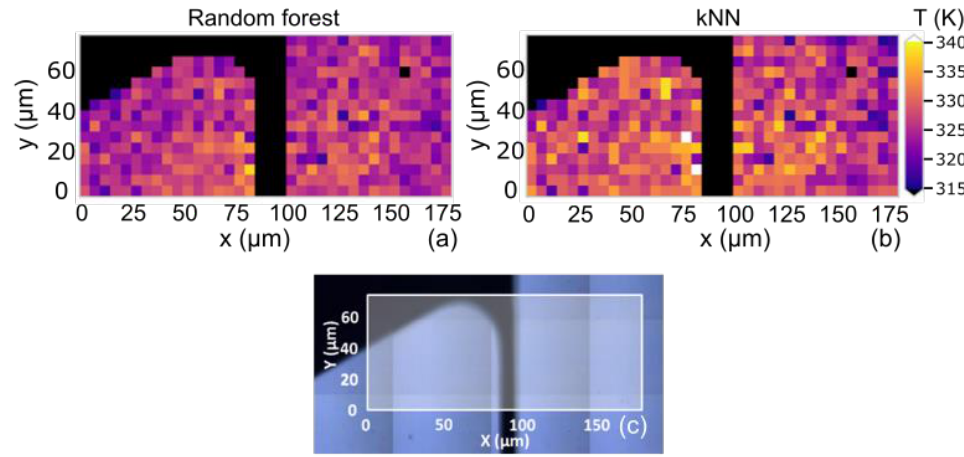
Figure 6. Hyperspectral images showing the temperatures predicted by the ( a ) random forest and ( b ) k-NN machine learning algorithms. The regions of the metallic gold wire are masked in black. ( c ) Optical image with the metallic gold coating (black) on a PMMA thin film (blue) and the sampled area of the hyperspectral imaging in